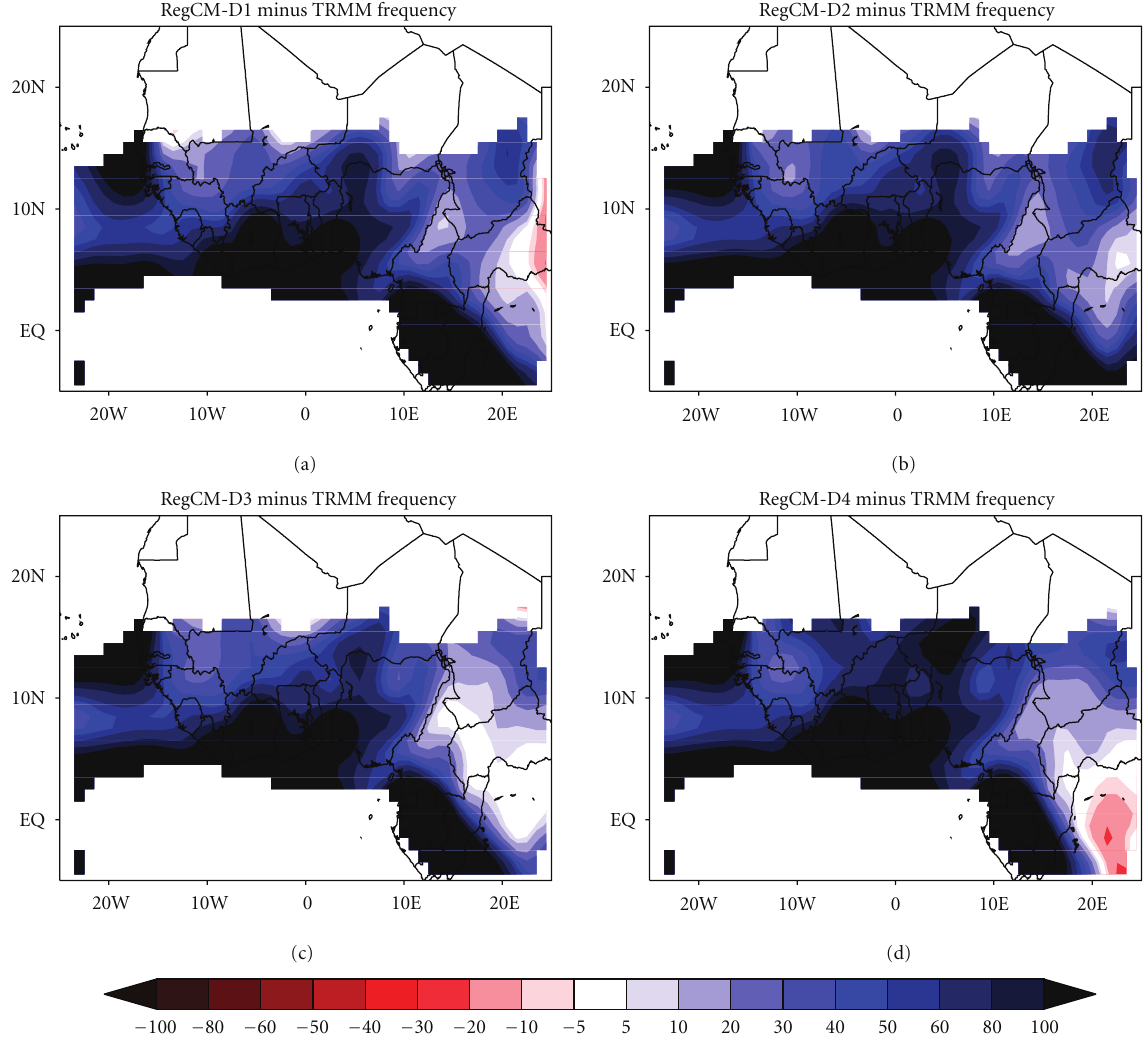
Figure 5: Di ff erences in mean number of rainfall events between (a) RegCM-D1 and TRMM, (b) RegCM-D2 and TRMM, (c) RegCM-D3 and TRMM, and (d) RegCM-D4 and TRMM. Units are expressed as percentage of TRMM